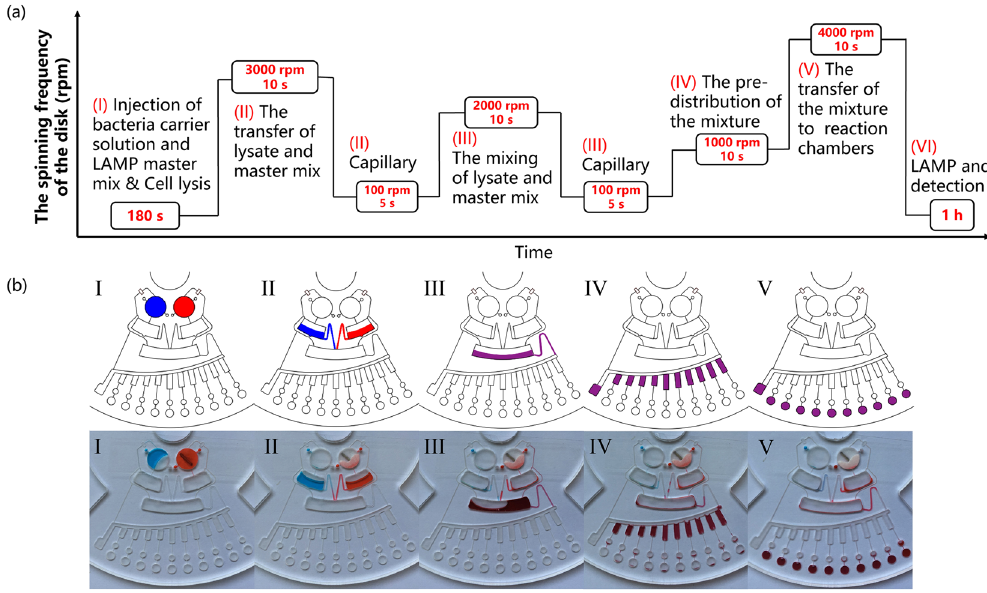
Figure 3. Spin protocol of the complete assay ( a ) and the corresponding illustrations and photos of each step ( b